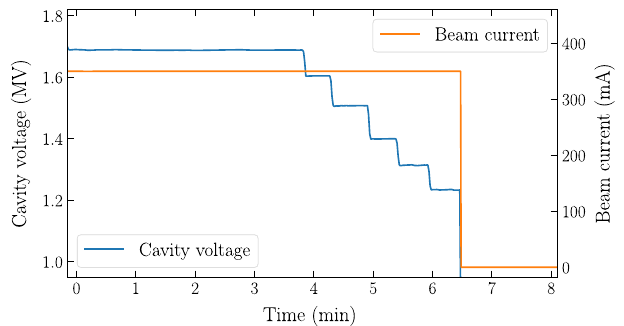
FIG. 4. The cavity voltage and average beam current during the experiment. In this example, the beam dumped at a cavity voltage between 1.23 and 1.15 MV.